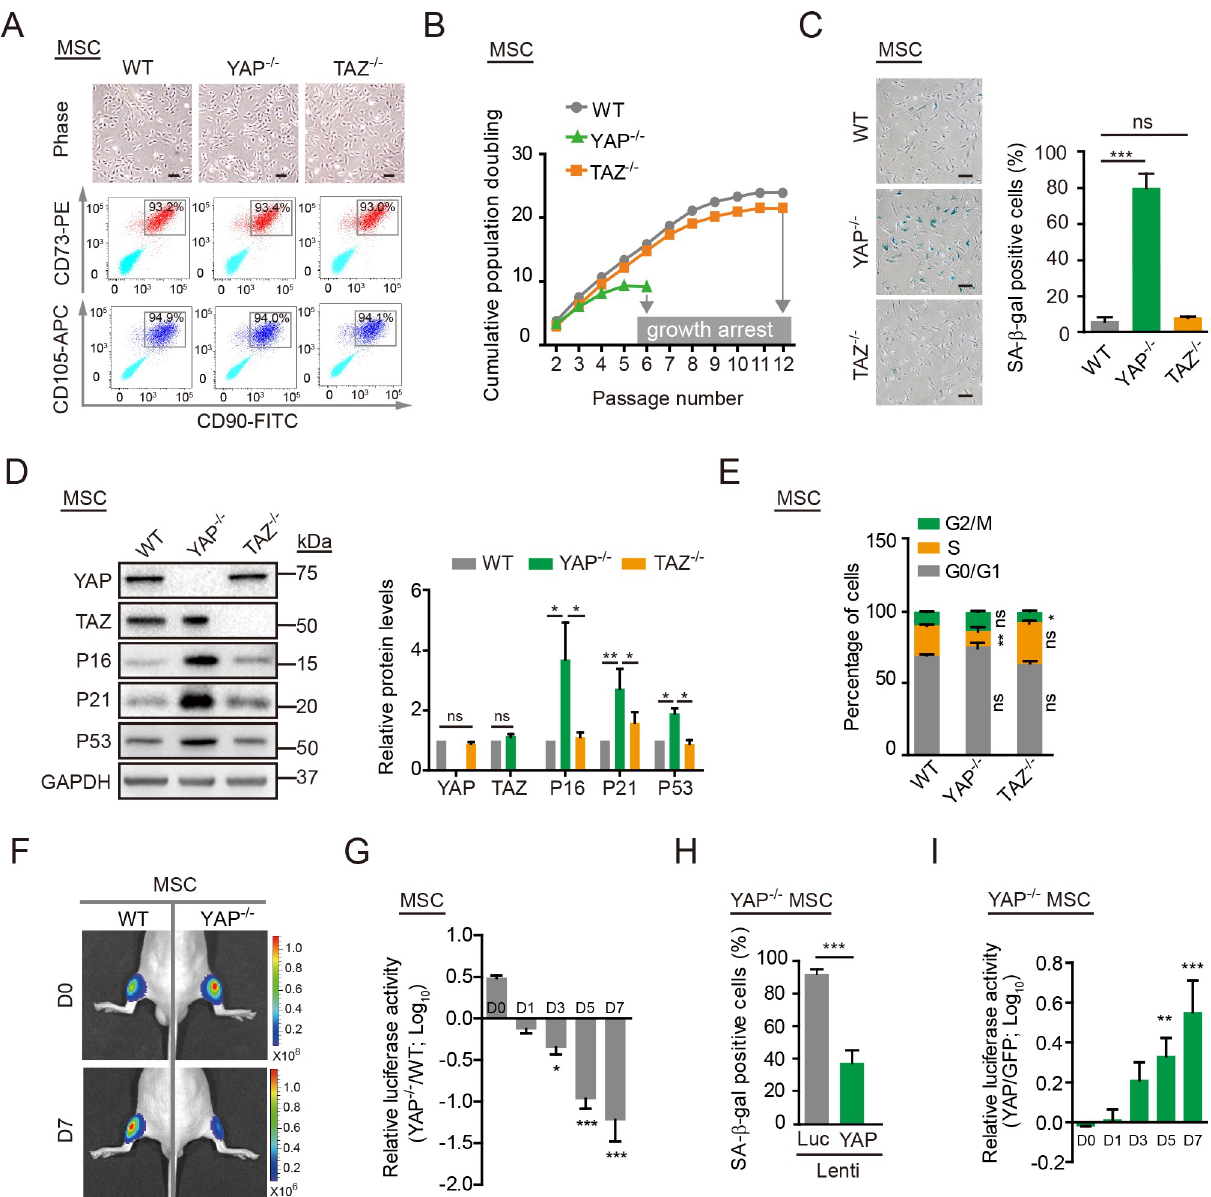
Fig 2. YAP − / − hMSCs exhibit accelerated senescence. (A) Brightfield micrographs and FACS analysis of the surface markers CD105, CD73, and CD90 in WT, YAP − / − , and TAZ − / − hMSCs. Scale bar, 50 μ m. (B) Cell growth curves of WT, YAP − / − , and TAZ − / − hMSCs. Data are presented as the mean ± SD, n = 3. (C) SA- β -gal staining of WT, YAP − / − , and TAZ − / − hMSCs at passage 4. Scale bar, 100 μ m. Data are presented as the mean ± SD, n = 3, ��� P < 0.001. (D) Western blot analysis of YAP, TAZ, P16, P21, and P53 in WT, YAP − / − , and TAZ − / − hMSCs. GAPDH was used as a loading control (left). The protein levels normalized with GAPDH were shown as fold change relative to WT hMSCs (right). Data are presented as the mean ± SD, n = 3, � P < 0.05, �� P < 0.01. (E) Cell cycle analysis of WT, YAP − / − , and TAZ − / − hMSCs. Data are presented as the mean ± SD, n = 3, � P < 0.05, �� P < 0.01. (F) WT and YAP − / − hMSCs transduced with a lentivirus expressing Luc were injected into the TA muscle of immunodeficient mice. Luc activities were imaged at day (D)0, D1, D3, D5, and D7 after cell implantation. Representative images at D0 and D7 are shown. (G) Data are presented as the ratios of YAP − / − to WT cells (log 10 (fold)), mean ± SD, n = 5, � P < 0.05, ��� P < 0.001. (H) SA- β -gal staining of YAP − / − hMSCs transduced with lentiviruses expressing Luc or YAP. Data are presented as the mean ± SD, n = 3, ��� P < 0. 001. (I) YAP − / − hMSCs overexpressing GFP plus Luc and YAP − / − hMSCs overexpressing YAP plus Luc were implanted into the TA muscles of immunodeficient mice. The Luc activities were measured at different time points after cell implantation. Data are presented as the ratios of YAP to GFP (log 10 (fold)), mean ± SD, n = 5, �� P < 0.01, ��� P < 0.001. The numerical data underlying this figure are included in S8 Data. APC, allophycocyanin; CD, cluster of differentiation; D, day; FACS, fluorescence activated cell sorter; FITC, fluorescein isothiocyanate; G, gap; GAPDH, glyceraldehyde-3-phosphate dehydrogenase; GFP, green fluorescent protein; hMSC, human mesenchymal stem cell; Lenti, lentivirus; Luc, luciferase; M, mitosis; MSC, mesenchymal stem cell; ns, not significant; PE, phycoerythrin; S, synthesis; SA- β -gal, senescence-associated- β -galactosidase; TA, tibialis anterior; TAZ, transcriptional coactivator with PDZ-binding motif; WT, wild type; YAP, Yes-associated